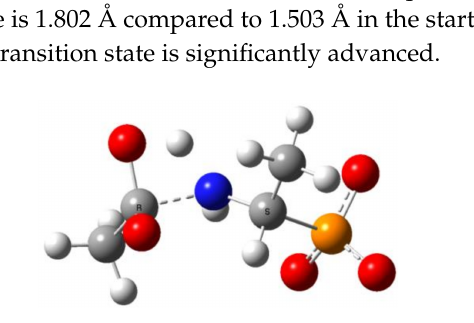
Figure 11. The transition state for proton transfer/dissociation of the C-N bond in Ac(OH)-Ala P(3 − ) . The Gibbs free energies for the dissociation reaction 1.2 in the gas phase and in water are presented in Tables 6 and 7,